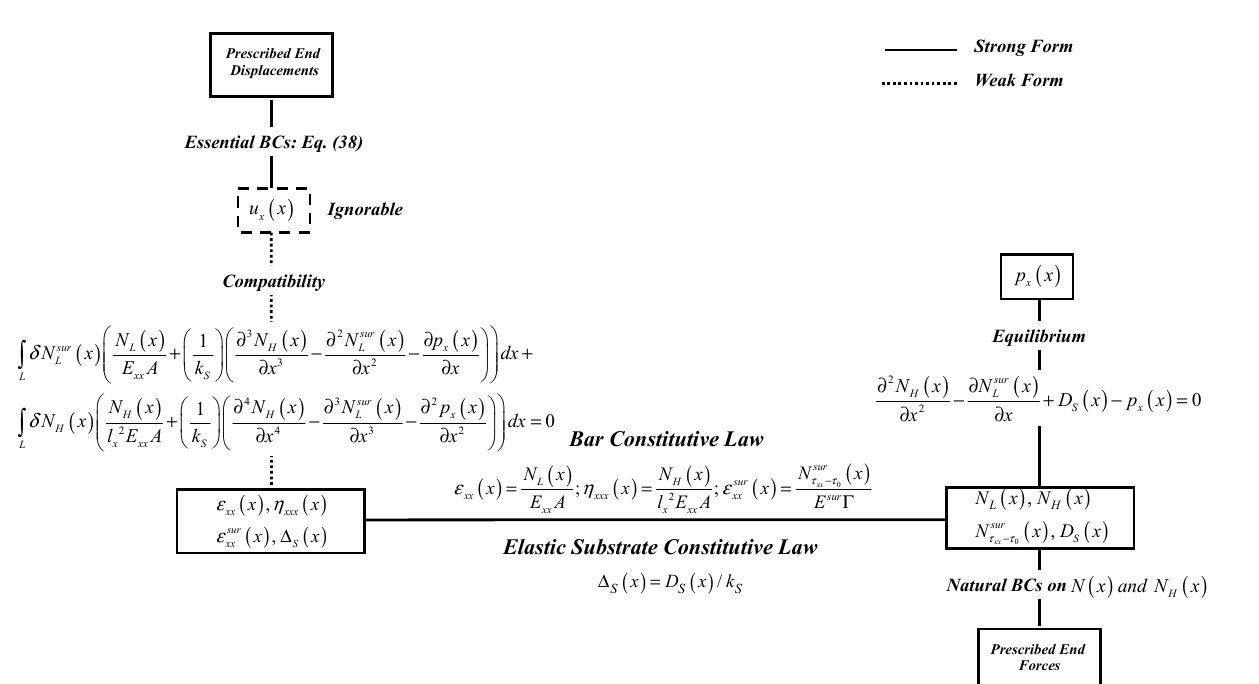
Figure 4. Modified Tonti’s diagram for nanobar-elastic substrate system: The virtual-force formulation.